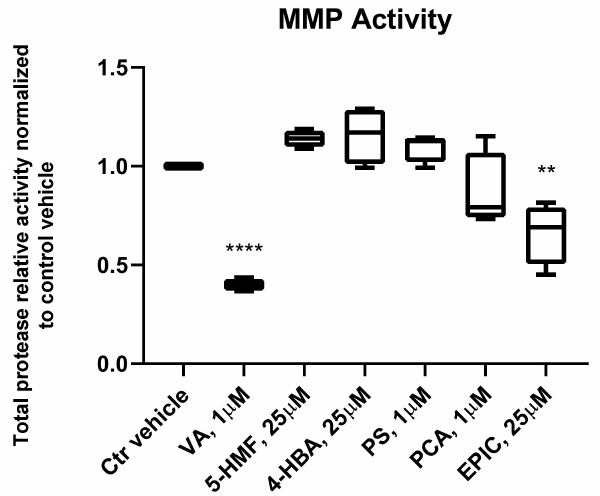
Figure 3. Matrix metalloproteinase (MMP) activity assay for the treated groups with VA, 5-HMF, 4-HBA, PS, PCA, and Epi C versus control vehicle (Ctr vehicle) group. MMP activity in the conditioned medium of osteoarthritic chondrocytes microtissues was measured in phase III. For the treatment groups with VA and Epi C MMP activity was significantly decreased compared to Ctr vehicle group. Total protease activity as the average relative fluorescence units (RFU) of 4 independent donors is shown. n = 4; n indicates the number of human OA chondrocytes donors; for each donor, three experimental replicates were analyzed. For statistical analysis using Graphpad Prism, one-way analysis of variance (ANOVA) followed by Dunnett’s post hoc test (multiple comparisons) was applied. ** p < 0.001, **** p < 0.0001 vs. Ctr